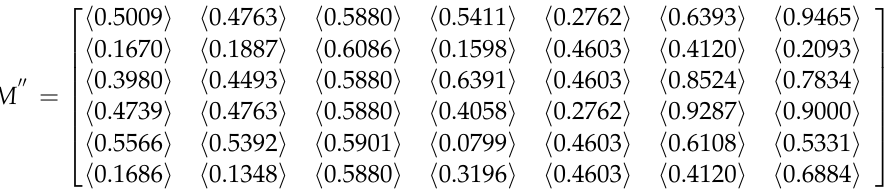
Table 6. The relative loss functions of Example 1.